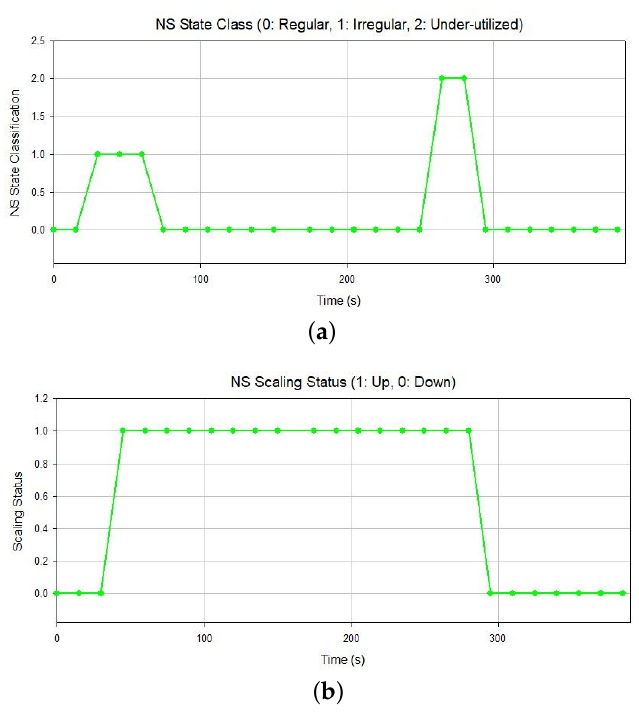
Figure 9. NS state class and scaling status. ( a ) NS state classification; ( b ) NS scaling